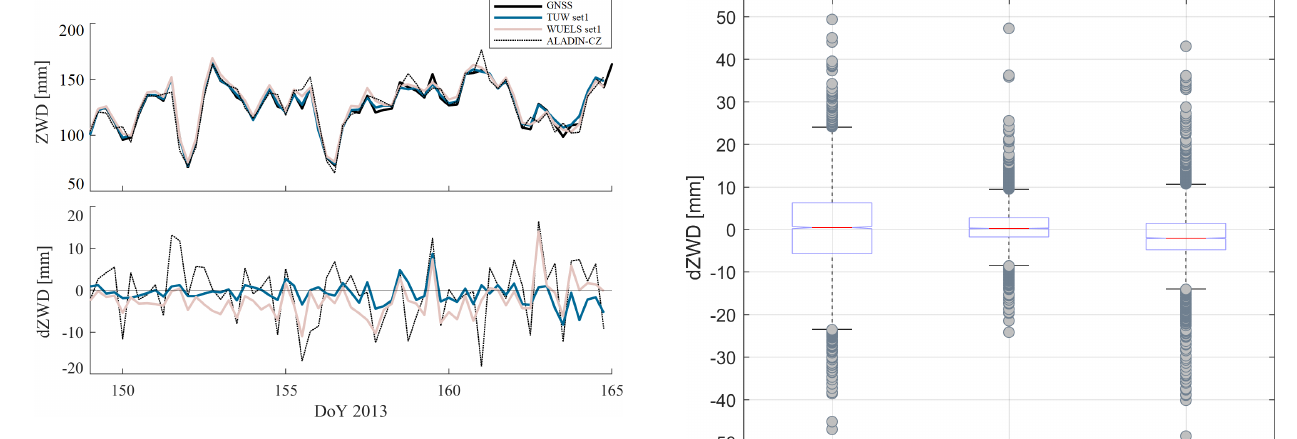
Figure 6. GNSS-derived (black) and tomography-derived (blue and red) ZWD time series at GNSS site WTZR (Wettzell, Germany). The dashed line shows the ZWD values derived from the ALADIN- CZ model. The top plot shows the absolute values and the bottom plot highlights the ZWD differences with respect to the GNSS- derived ZWDs.